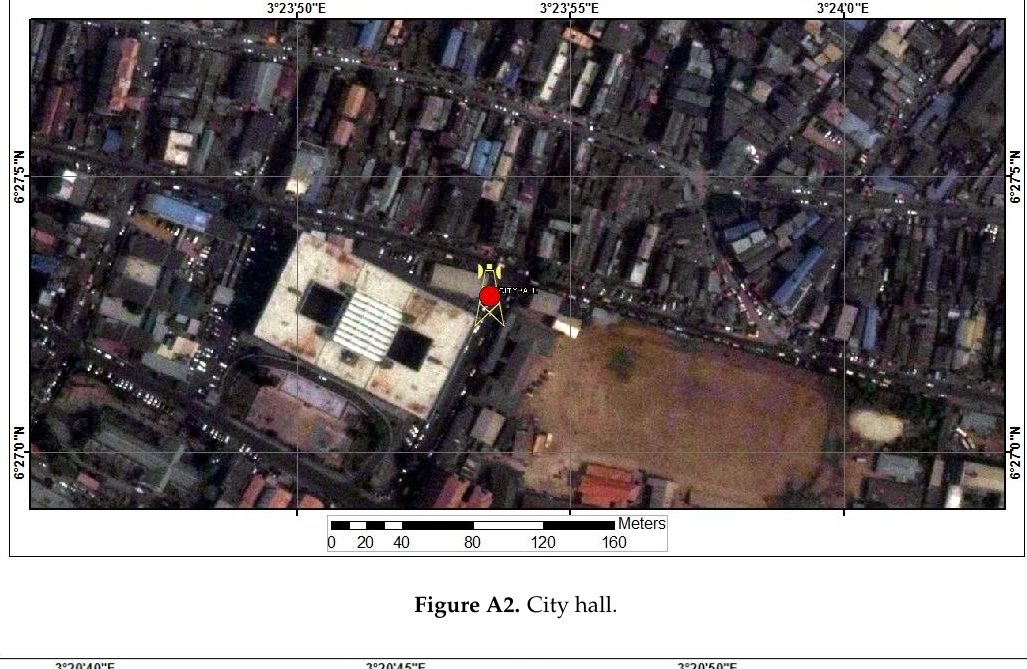
Figure A2. City hall.